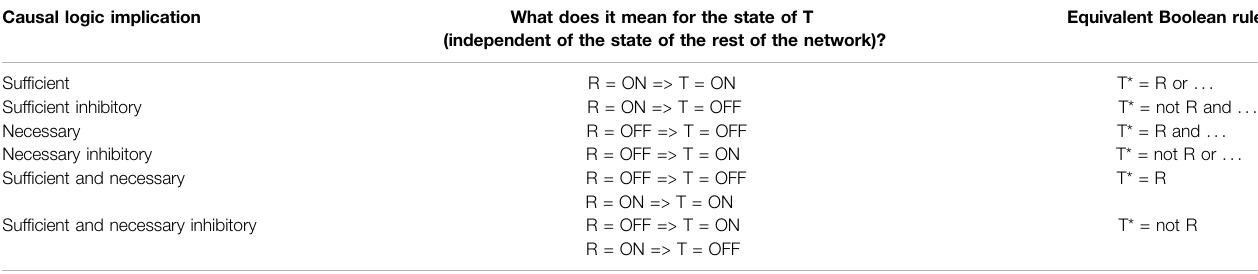
TABLE1| Summaryofthesixdifferenttypesofcausallogicimplicationandtheircorrespondencewiththedirecteffectofthestateoftheregulatornode(R)onthestateofthe target node (T). The fi rst column lists the causal logic implication, the second column lists what that implication indicates about the de fi nite knowledge of the state of the targetnodeifthestateoftheregulatornodeisknown,andthethirdcolumnliststhecorrespondingBooleanrules.The “ ... ” intheBooleanruleisaplaceholderforanynumber of other regulators of the target node. The asterisk (*) denotes a future state of a node, i.e., T* refers to the future (or next timestep) state of the target node. Causal logic implication What does it mean for the state of T (independent of the state of the rest of the